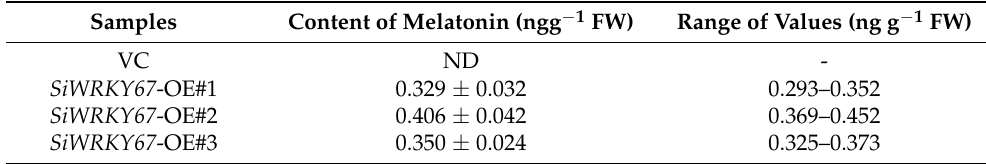
Table 2. Content of melatonin in SiWRKY67 -OE hairy root